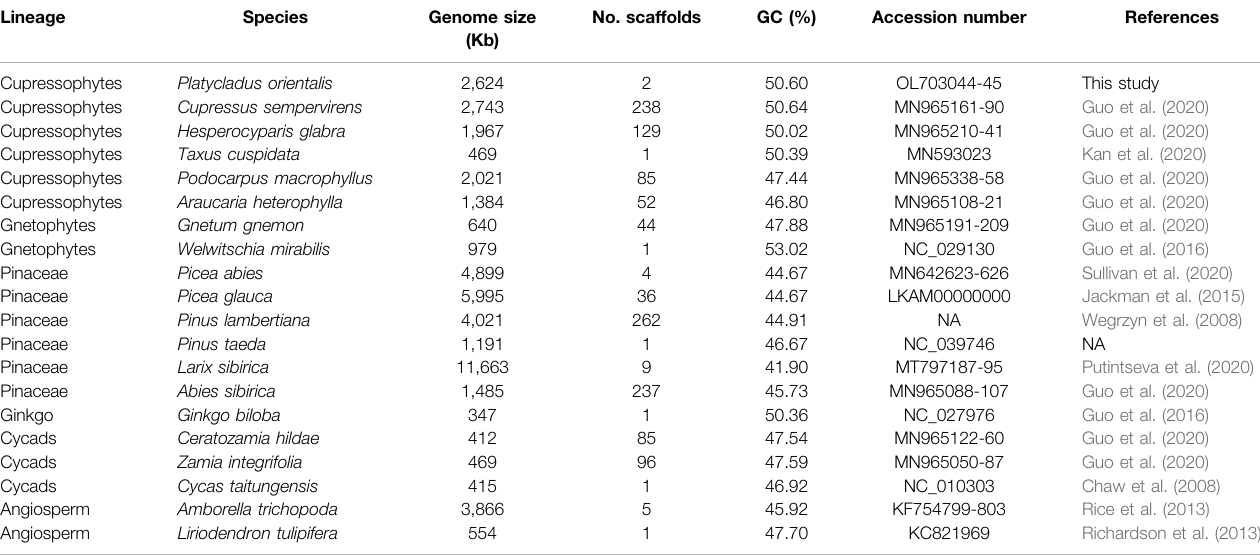
TABLE 1 | Summary of the 20 plant